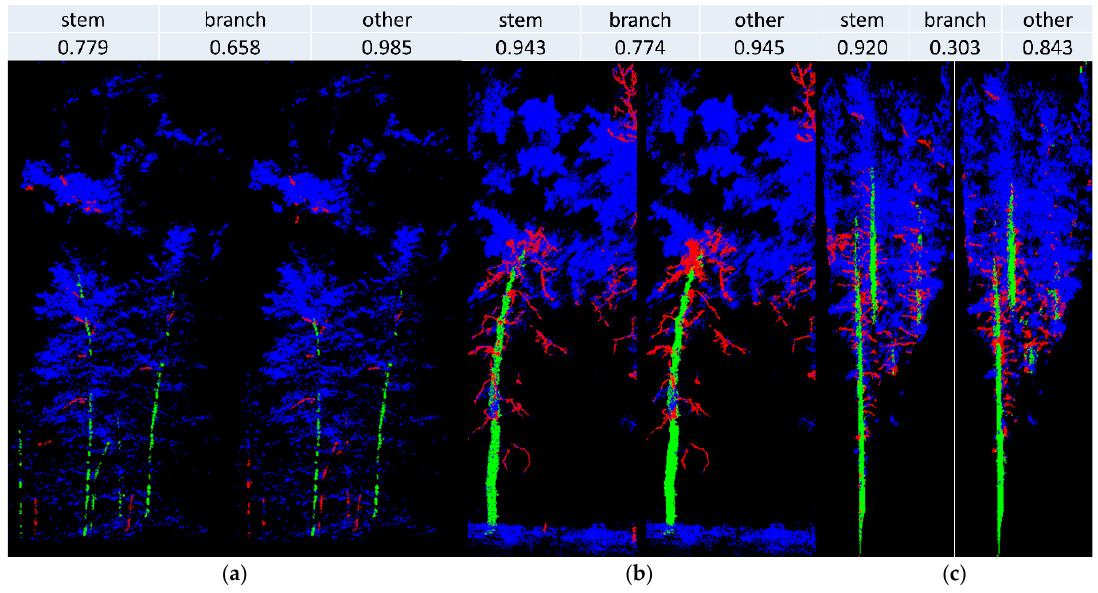
Figure 8. Visualization of reference trees (left of each panel) and filtered trees (right of each panel) from testing dataset, including ( a ) ‘maple 7’, ( b ) ‘aspen 8’, and ( c ) ‘pine 4’. Per-class IoU is denoted on top of each panel. Stem, branch, and other points are in green, red, and blue colors, respectively.